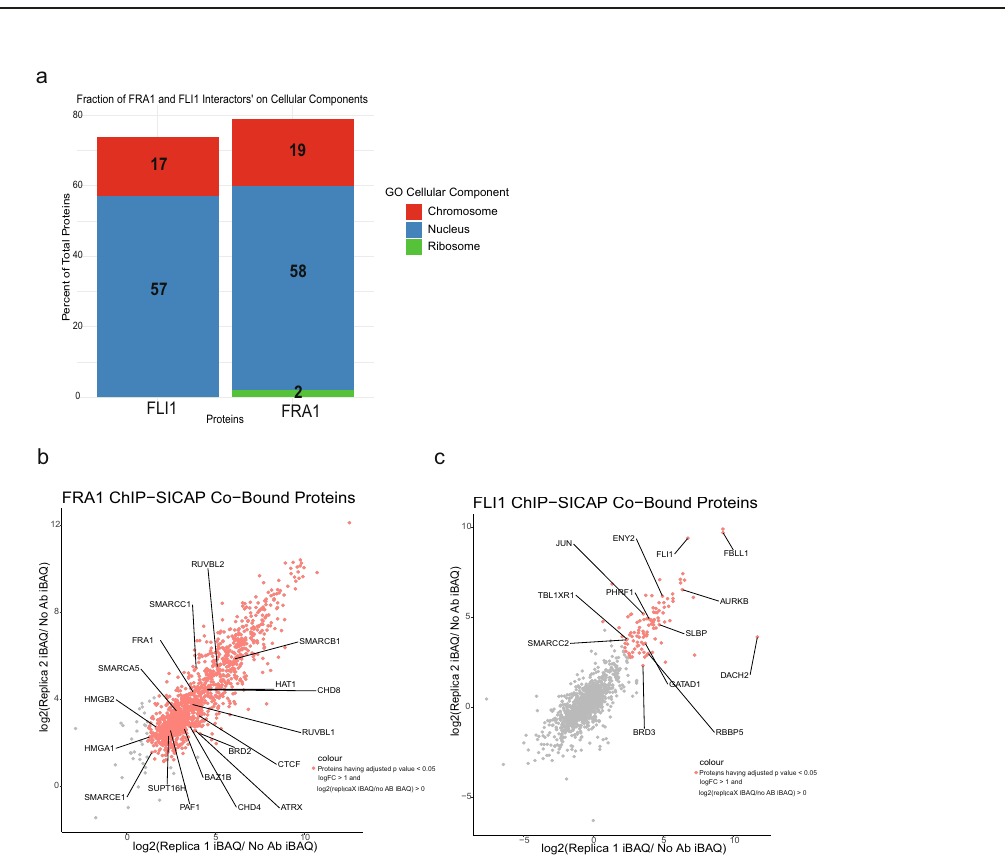
Fig. 4 Knockdown of FRA1 and FLI1 downregulates the expression of genes involved in epithelial cell migration. a Barplots show the overlap rates of MIBC and NMIBC enhancers with FRA1 and FLI1 peaks. b Regulatory network denoting the transcription factors, FRA1 and FLI1 and their target genes involved in epithelium migration, cell junction organization and regulation of epithelial cell proliferation. For simplicity similar terms were left out of the visualized image (please see Supplementary Data 3, ‘ epithelium migration ’ and ‘ cell junction organization ’ , and ‘ regulation of epithelial cell proliferation ’ related terms are highlighted in yellow). c , d Plots showing the downregulation of FRA1 ( c ) and FLI1 ( d ) at mRNA and protein level. Top panels display the relative mRNA levels, bottom panels show the western blot images. e , f Barplots display the relative mRNA levels of FLOT1 ( e ) and MAP4K4 (f) (top panels). Snapshots showing H3K27ac, FRA1 and FLI1 signals at the MIBC enhancers regulating FLOT1 and MAP4K4 genes (bottom panels). Scale of the snapshots are adjusted to 25. Error bars show the standard deviation of two biological replicates. Each biological replicate is analyzed in three technical replicates.* p -value < 0.05, ** p -value < 0.01.